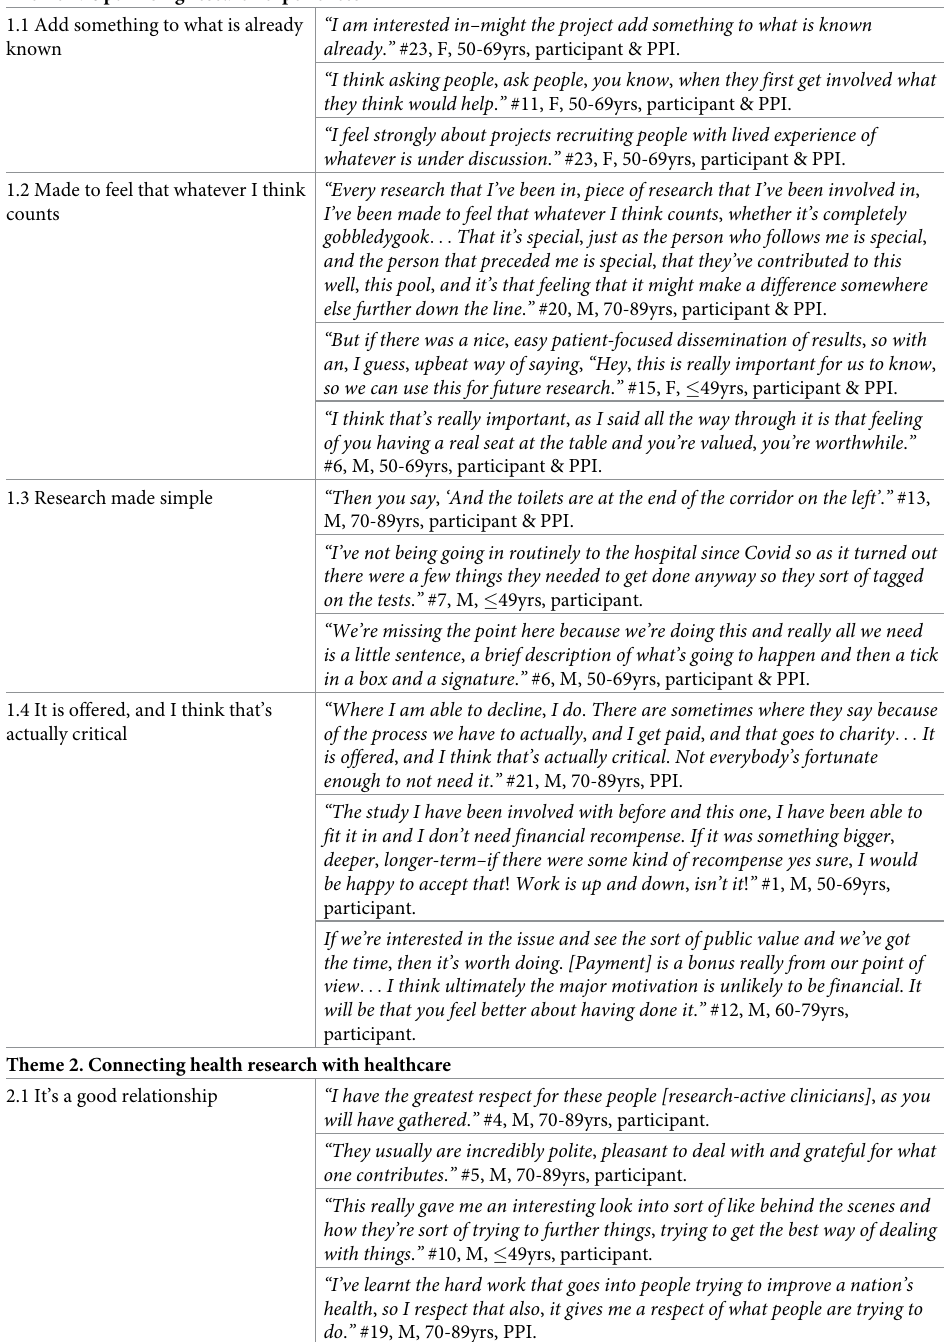
Table 3. Additional quotes to illustrate each theme and